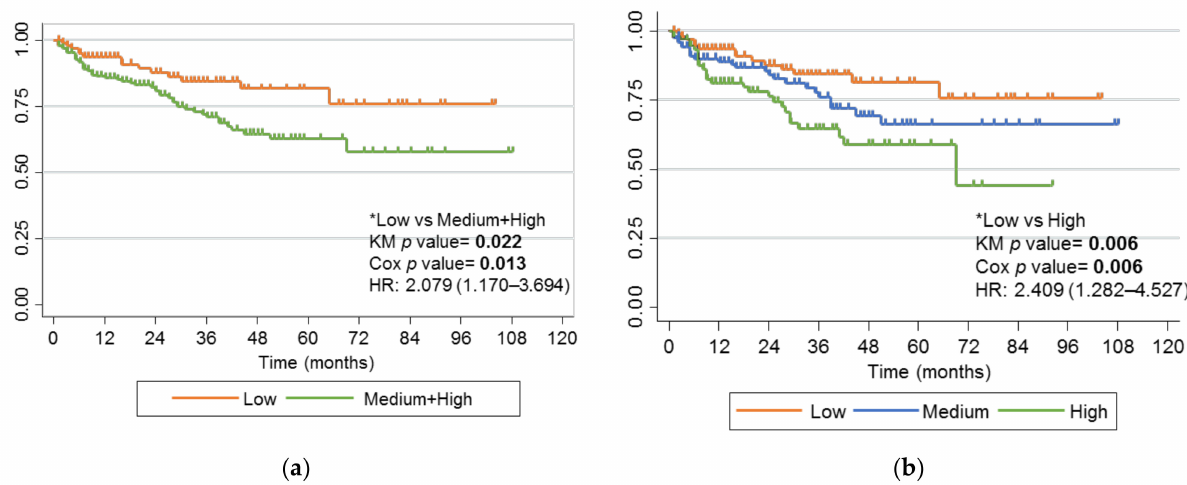
Figure 3. Kaplan-Meier curve of combined effect of rs2395185 and rs2097432 on failure of anti-TNF drugs. ( a ) Patients carrying a low-risk haplotype (orange) or any other haplotypes (green); ( b ) Patients carrying a low-risk haplotype (orange), a medium-risk haplotype (blue), or a high-risk haplotype (green). Genotype comparisons and p values for the univariate analysis (KM p value) and multivariate analysis (Cox p value) analyses are presented alongside Kaplan-Meier curves. Significant p values are marked in bold. * Reference